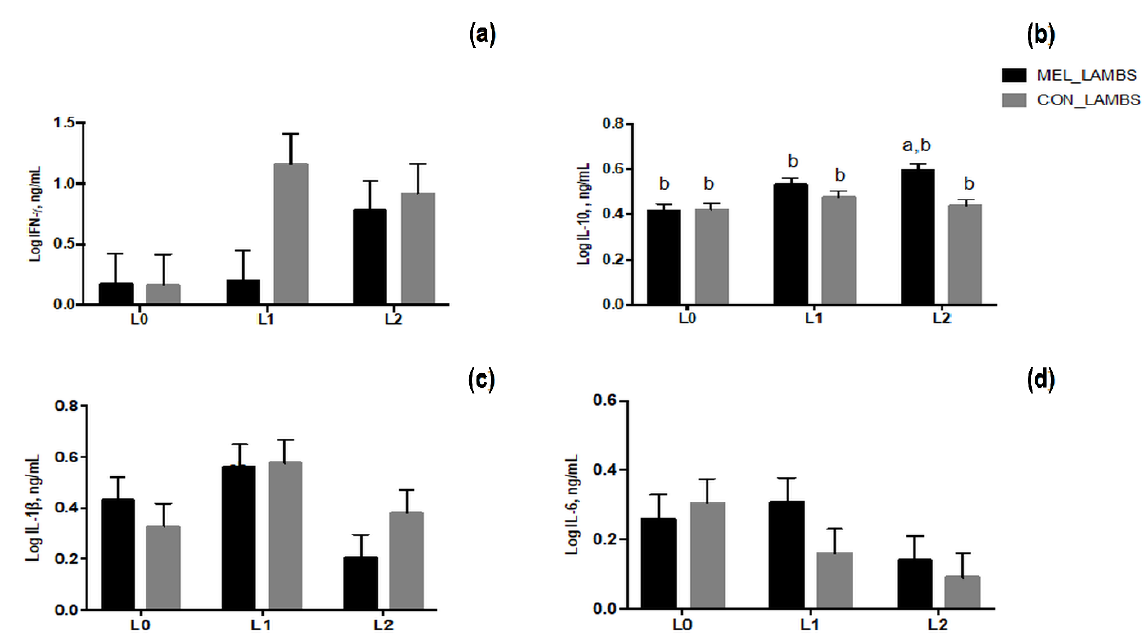
Figure 9. Least squares means ± SEM of levels of plasma IFN- γ ( a ), IL-10 ( b ), IL-1 β ( c ) and IL-6 ( d ) secretion at birth (L0), 24 h (L1) and 48 h later (L2) in lambs born from control ewes (CON) and from melatonin ewes (MEL), p < 0.05, a: among the two groups, b: within time.